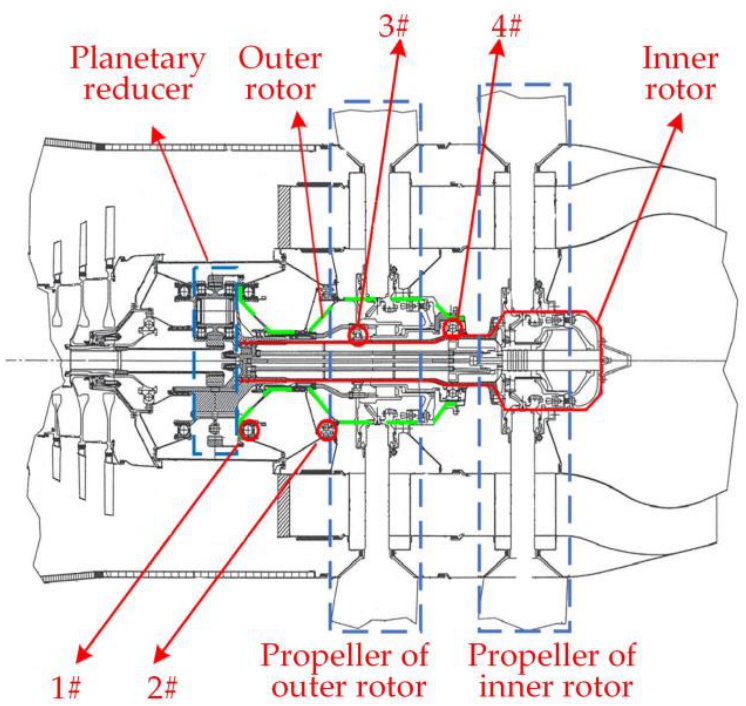
Figure 1. The coaxial counter-rotating dual-rotor structure at the output end of an open-rotor engine.